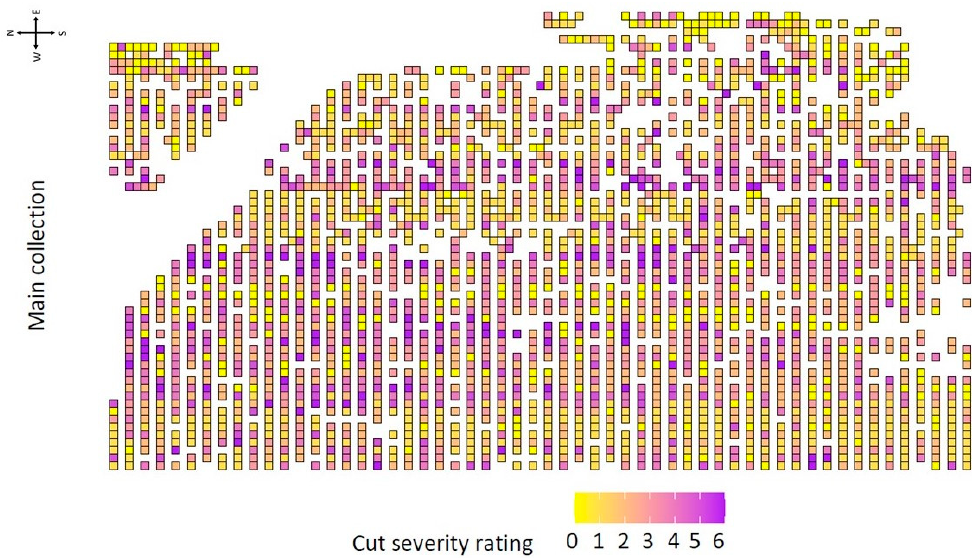
Figure 6. Heatmap of the main collection for cut severity ratings. Each tree is represented by a small box. Heavy cutting is observed throughout the orchard. White areas indicate no tree present. The cardinal directions of the field are shown in the top left corner.